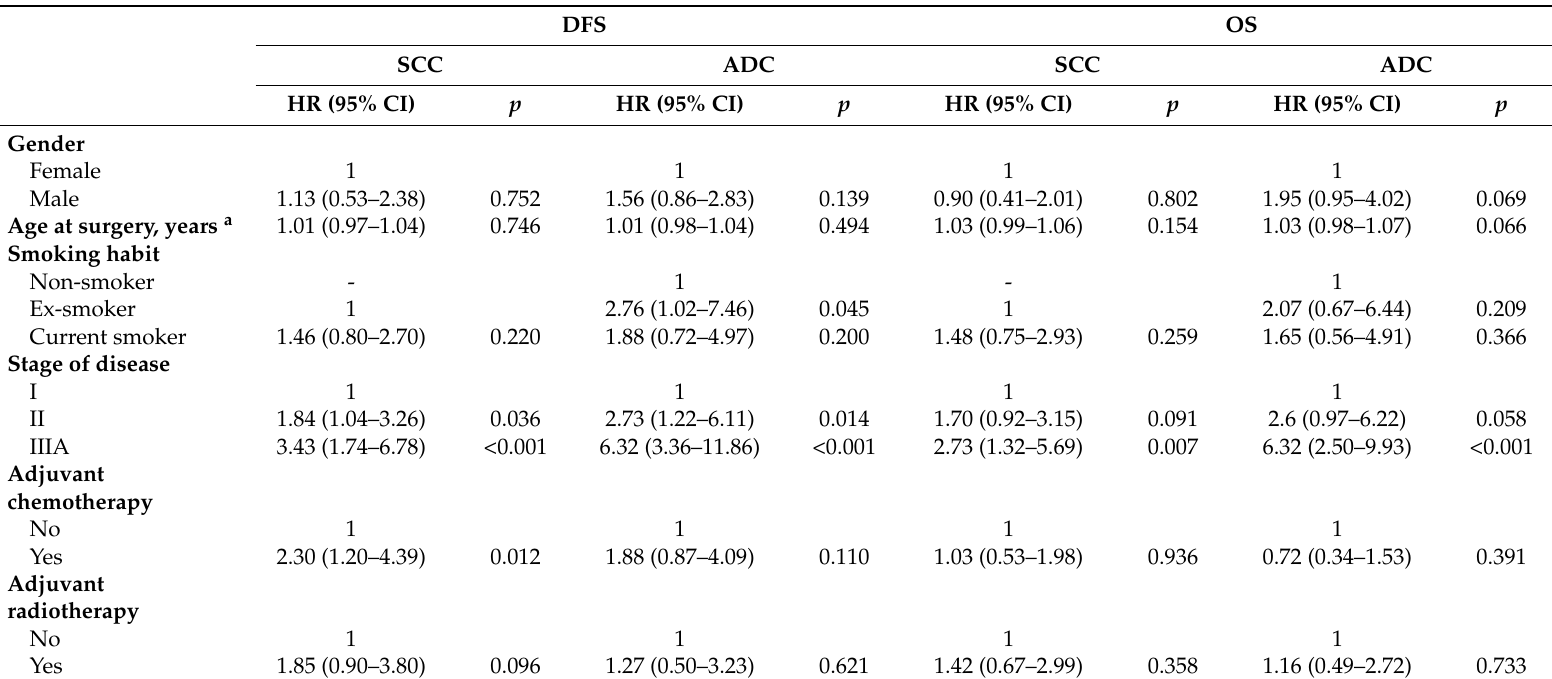
Table 2. Risk of relapse or death in squamous cell carcinoma (SCC) and adenocarcinoma (ADC) patients in relation to clinical-pathological characteristics.